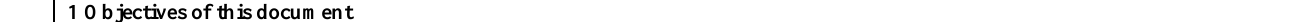
Table 1: Software Requirements